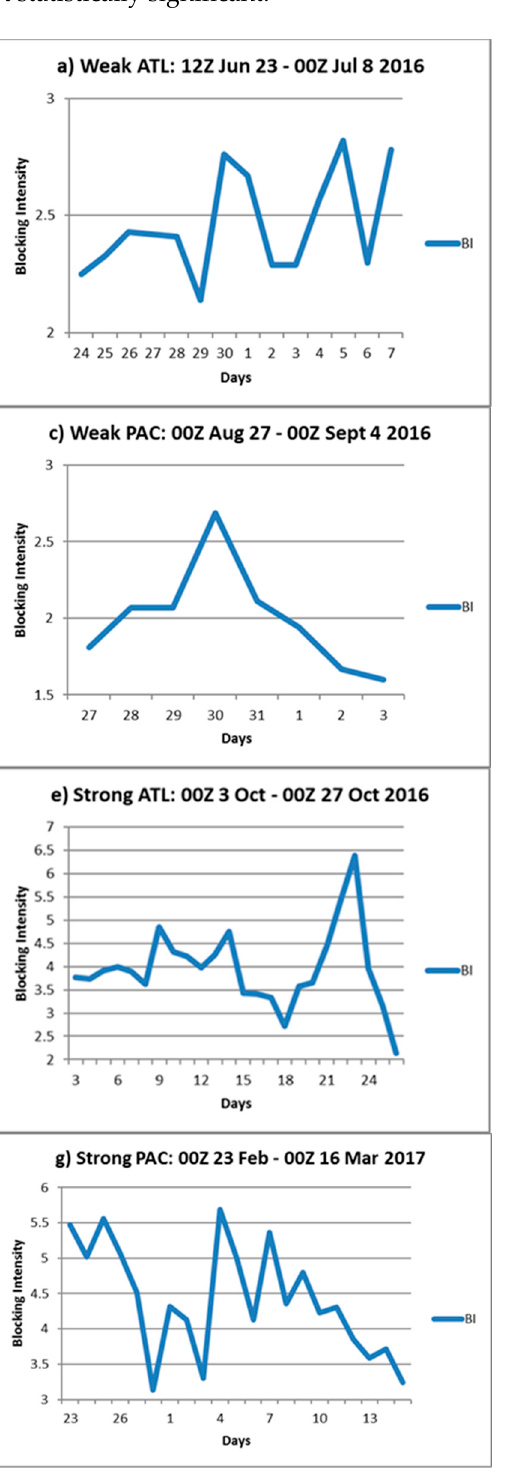
Figure 2. The ( a , c , e , g ) BI (no units) and ( b , d , f , h ) IRE (× 10 -8 s -2 ) for the weak Atlantic, weak Pacific, strong Atlantic, and strong Pacific blocking events,